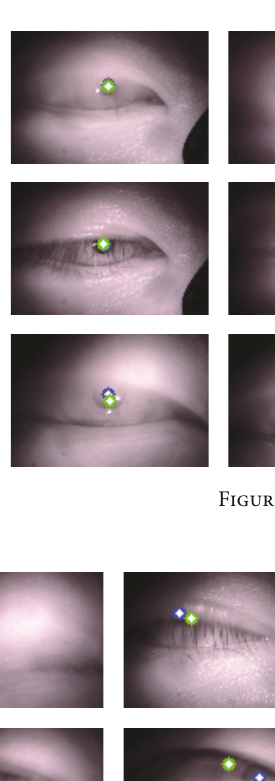
Figure 8: Success samples of open eye image.